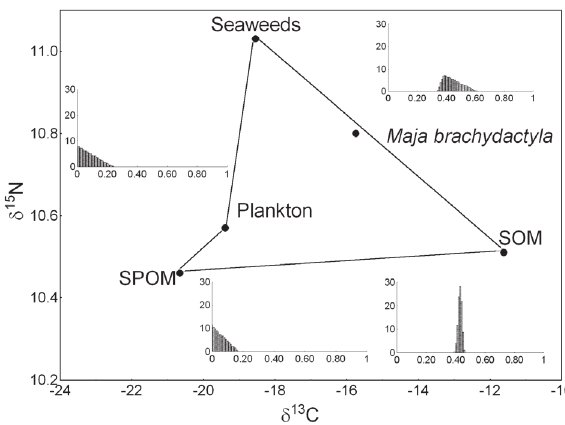
Fig . 7. – mixing polygon for δ 13 C and δ 15 n signatures of the po- tential organic matter sources for Maja brachydactyla in the Golfo artabro (after correcting for trophic fractionation). Histograms show the distribution of feasible contributions from each source to M. brachydactyla diet (percent frequency is represented in Y axis and source proportion in X